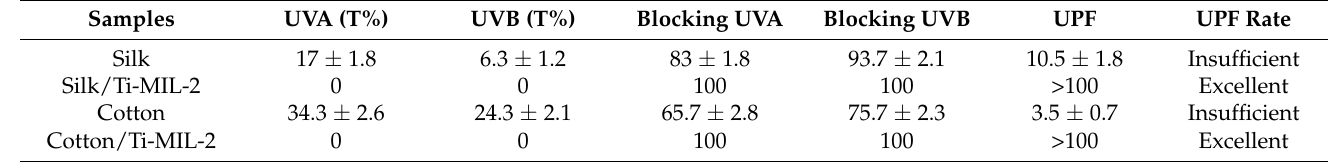
Table 4. UV blocking data for some of the developed anti-UV radiation textiles. Adapted from [99].